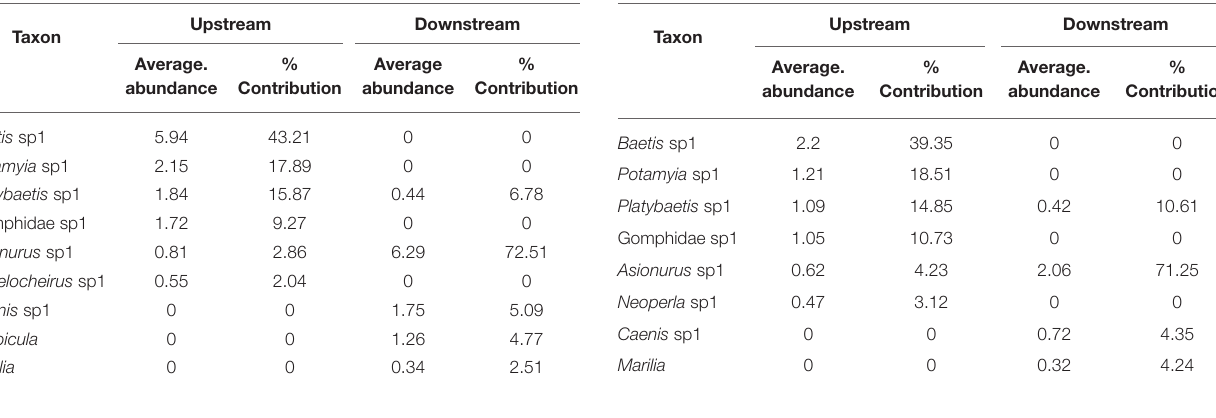
TABLE 5 | The percentage of contribution of EPTO taxa with their average abundance between sampling locations (upstream and downstream) of the